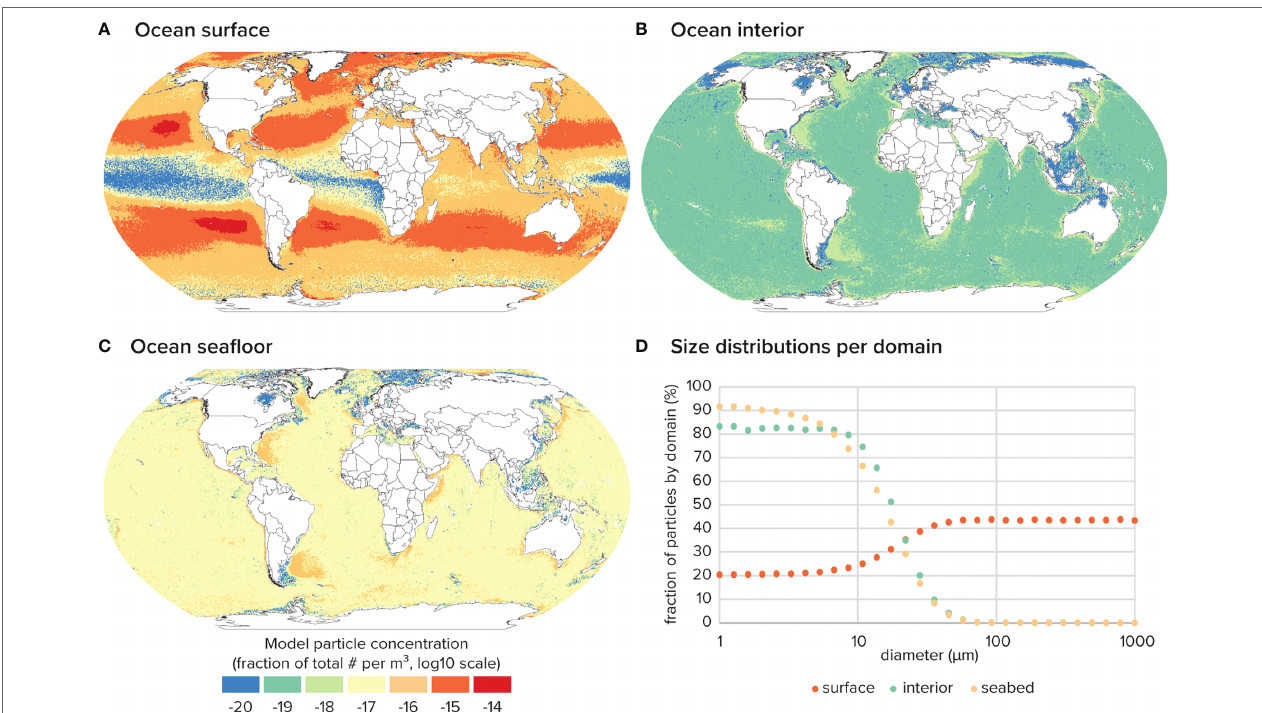
FIGURE 2 | Modelled distribution of small plastic particles (diameter < 1 mm) across different depth domains, average of 20 th model year. (A) Horizontal distribution at the “Ocean Surface.” (B) Horizontal distribution in the “Ocean Interior.” (C) Horizontal distribution at the “Ocean Seafloor.” (D) Comparison of size distribution between domains. Diameter is defined as 2*nominal